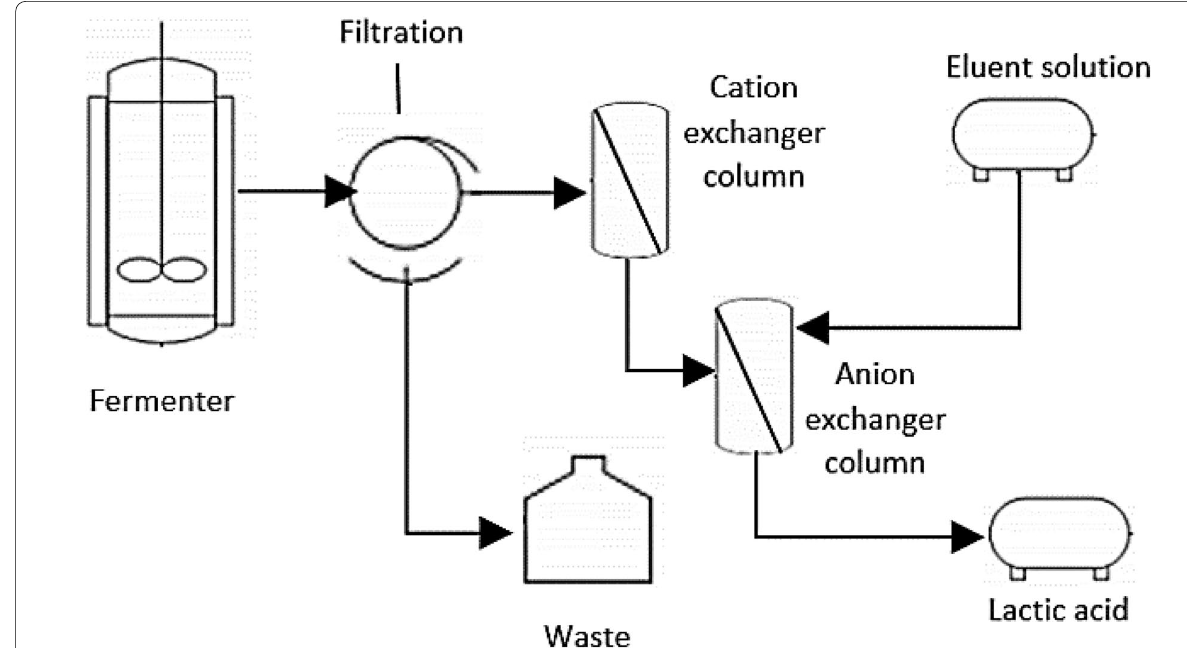
Fig. 1 Schematic diagram of extractive ion exchange lactic acid